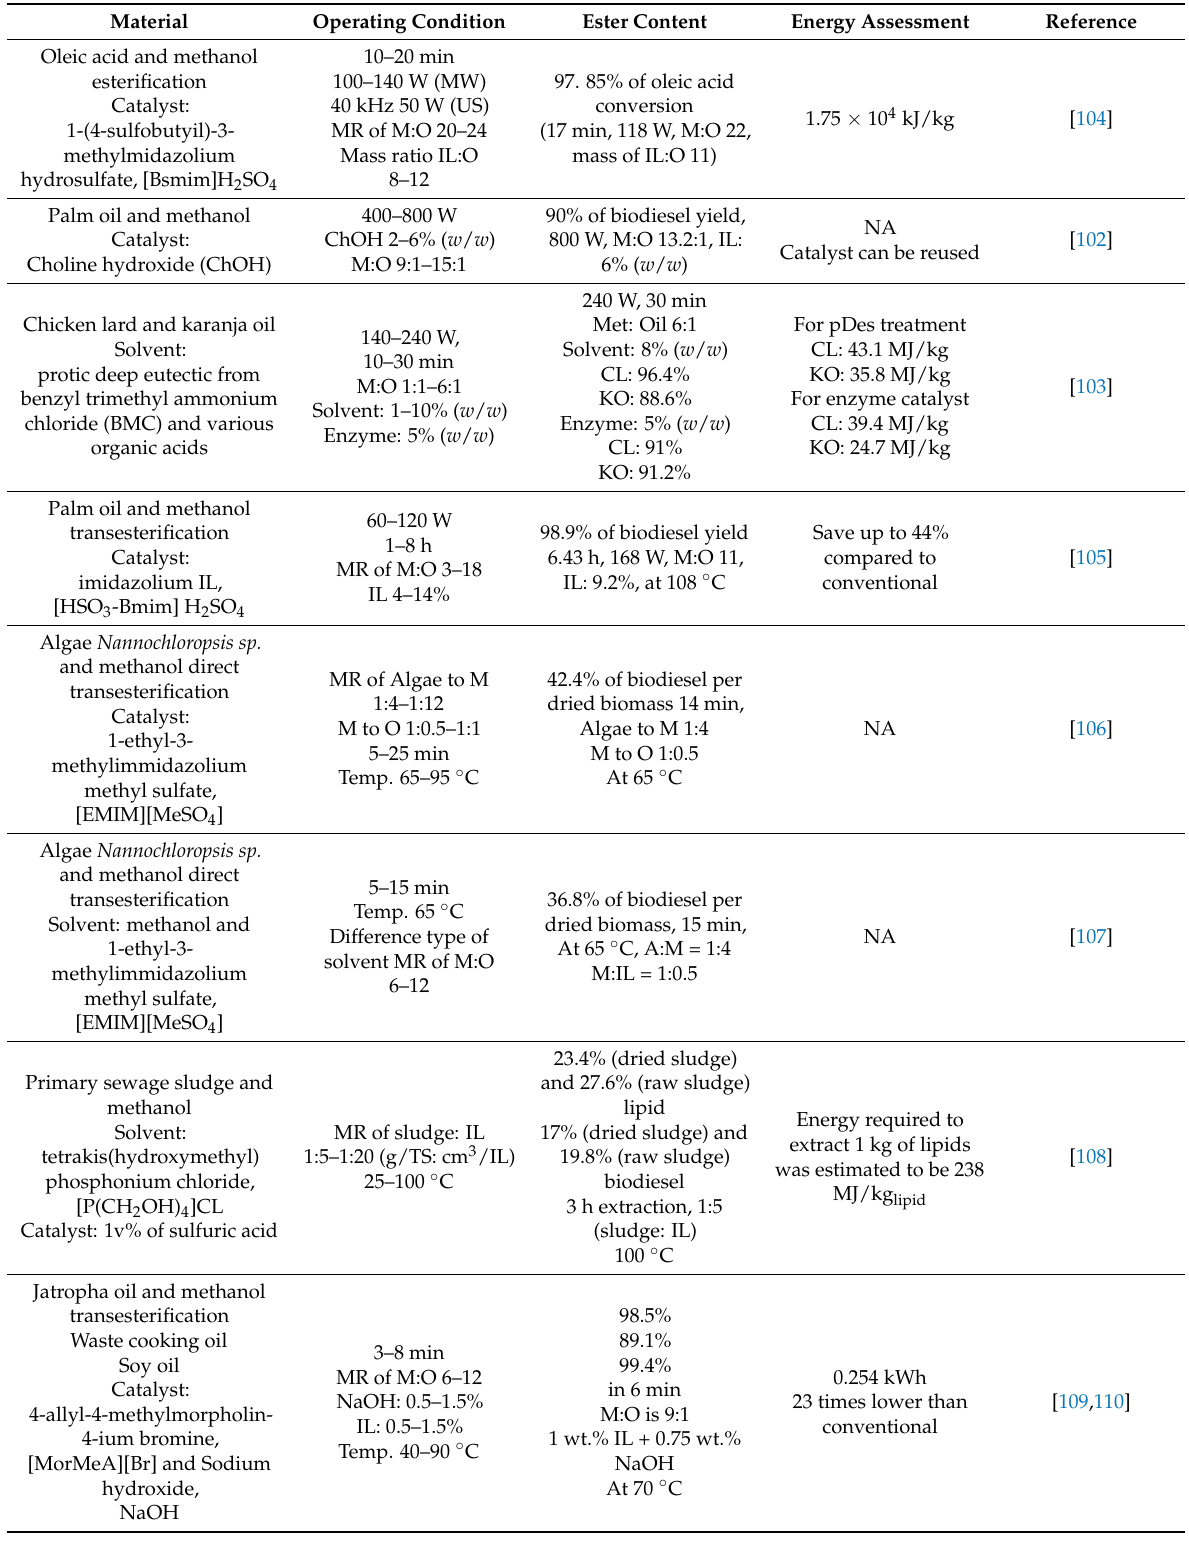
Table 6. Summary for microwave and ionic solvent